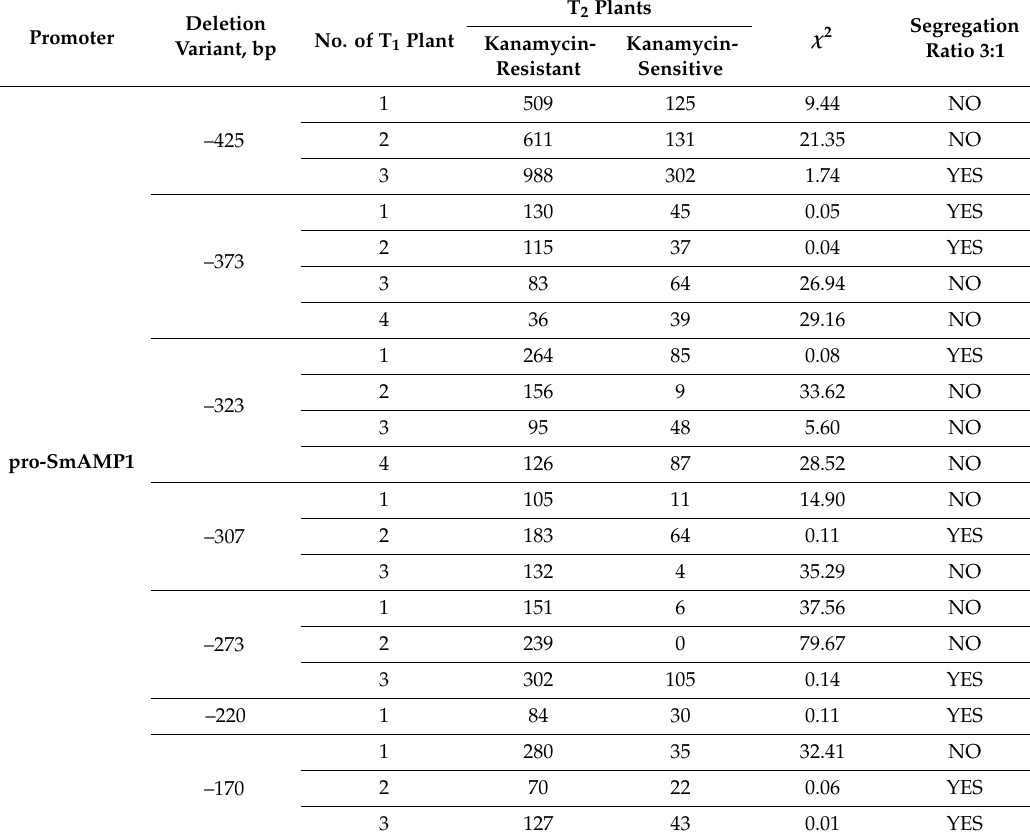
Table A3. The segregation of the T 2 Arabidopsis plants on selective